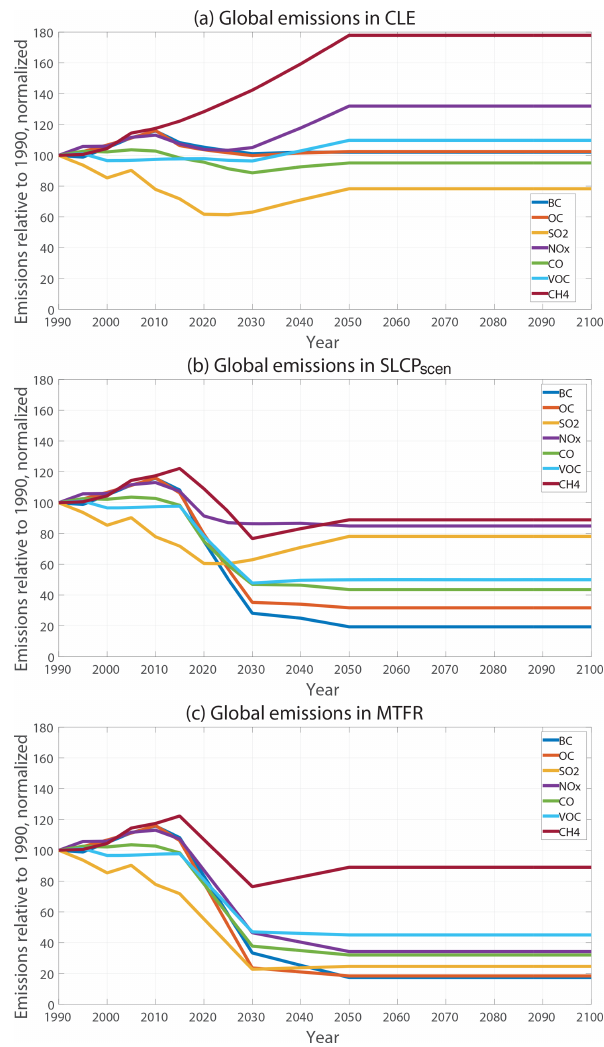
Figure 1. The global emission levels relative to the 1990 level for baseline (a) CLE, (b) SLCP scen , and (c) MTFR. The 1990 emission level for each SLCF is normalized to 100.